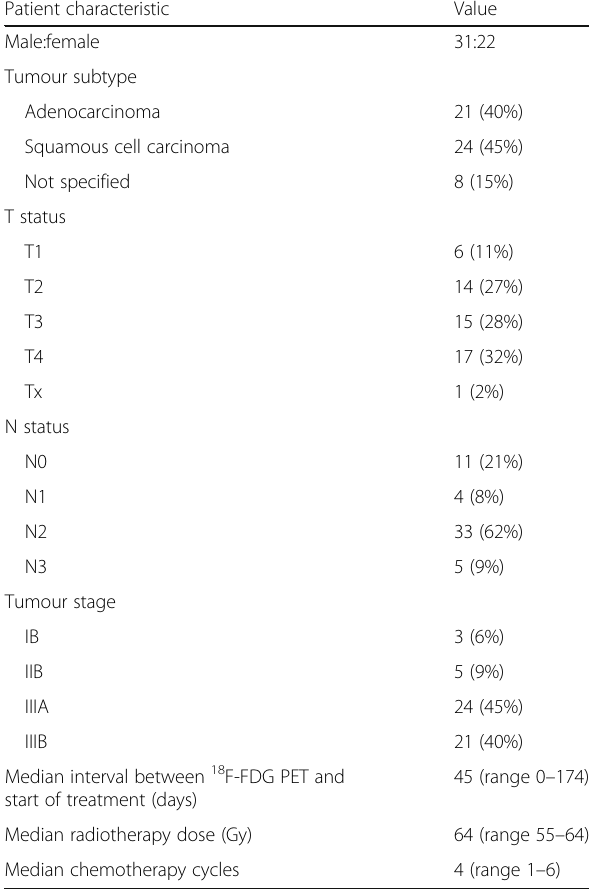
Table 1 Patient demographics and clinical characteristics Patient characteristic